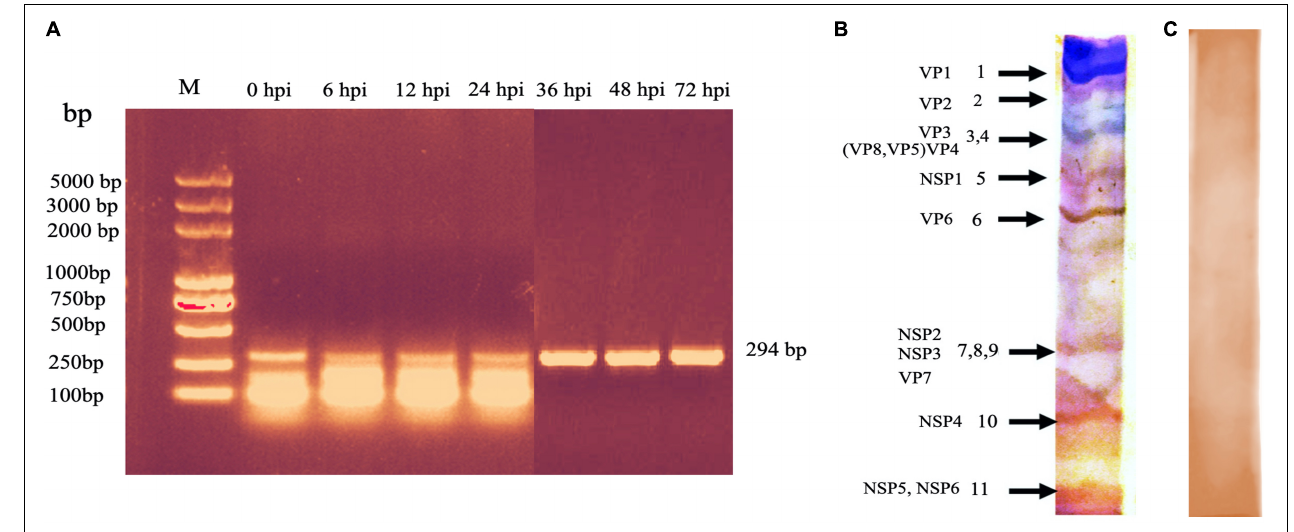
FIGURE 3 | PCR detection of the bovine rotavirus (BRV) isolate VP6 gene during the course of the virus inside the cell after infection (0–72 hpi) and detection of the 11 genome segments of BRV by SDS–PAGE. (A) Amplicon of the VP6 gene segment (294 bp). M : DNA ladder DL5000bp; lanes 1 – 7 , samples from cell culture harvest. The bands were visualized in 1% TS-GelRed stain in agarose gel. (B) RNA profile of group A BRV isolate. Typical RNA migration pattern showed that segments 7 , 8 , and 9 very close to each other, producing one segment, while segments 3 and 4 appeared as one segment. (C) Negative control of the SDS–PAGE